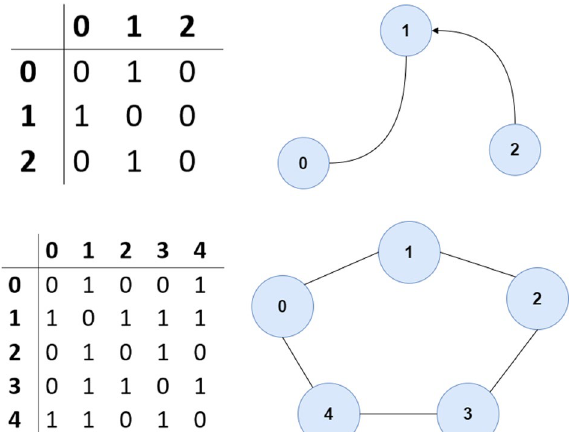
Fig. 1 Adjacency matrix (left) to graph/network